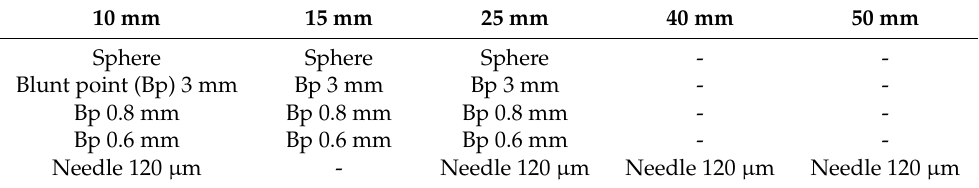
Table 1. Configurations for inhomogeneity tests under lightning impulse (LI) at negative